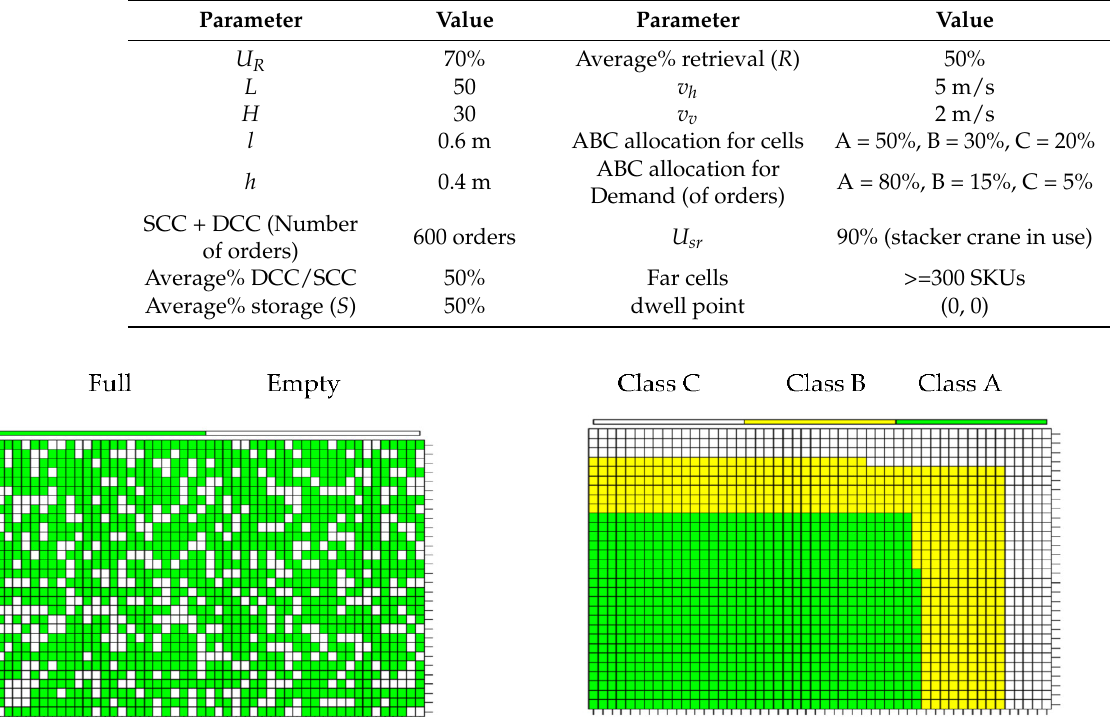
Table 1. Initial values of study parameters.